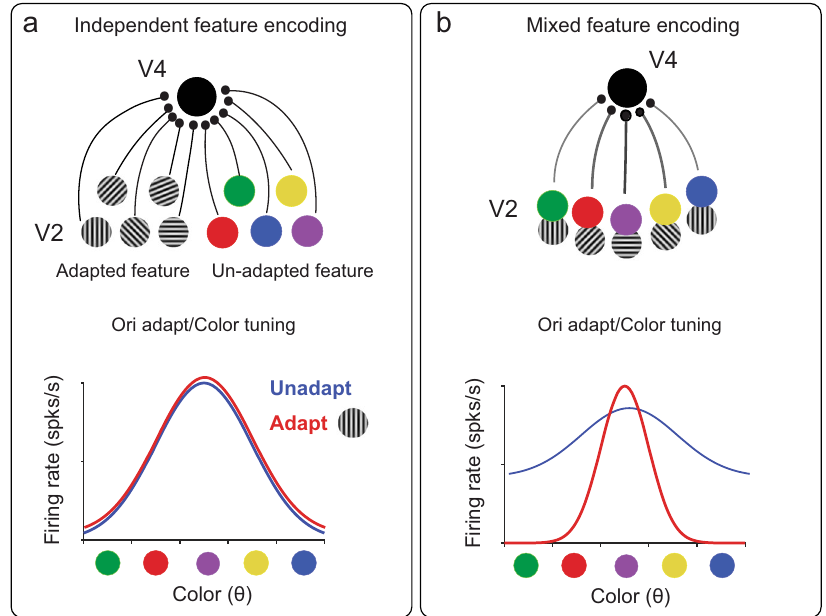
Fig. 5|Cross-featureadaptationinvolvesmixedfeatureselectivity ofinputsto area V4. a Top: A target V4 neuron (solid black circle) receives heterogeneous orientation and color inputs from upstream neurons (e.g., in area V2) via anato- mically non-overlapping/distinct set of channels for each feature (independent feature encoding). This neuron is adapted to a vertical grating (orientation adap- tation) and its tuning to color (unadapted feature) is tested. Bottom: Schematic representationoftuning curvesbefore(blue)andafteradaptation(red)consistent with independent feature encoding, i.e., adaptation to oriented gratings does not